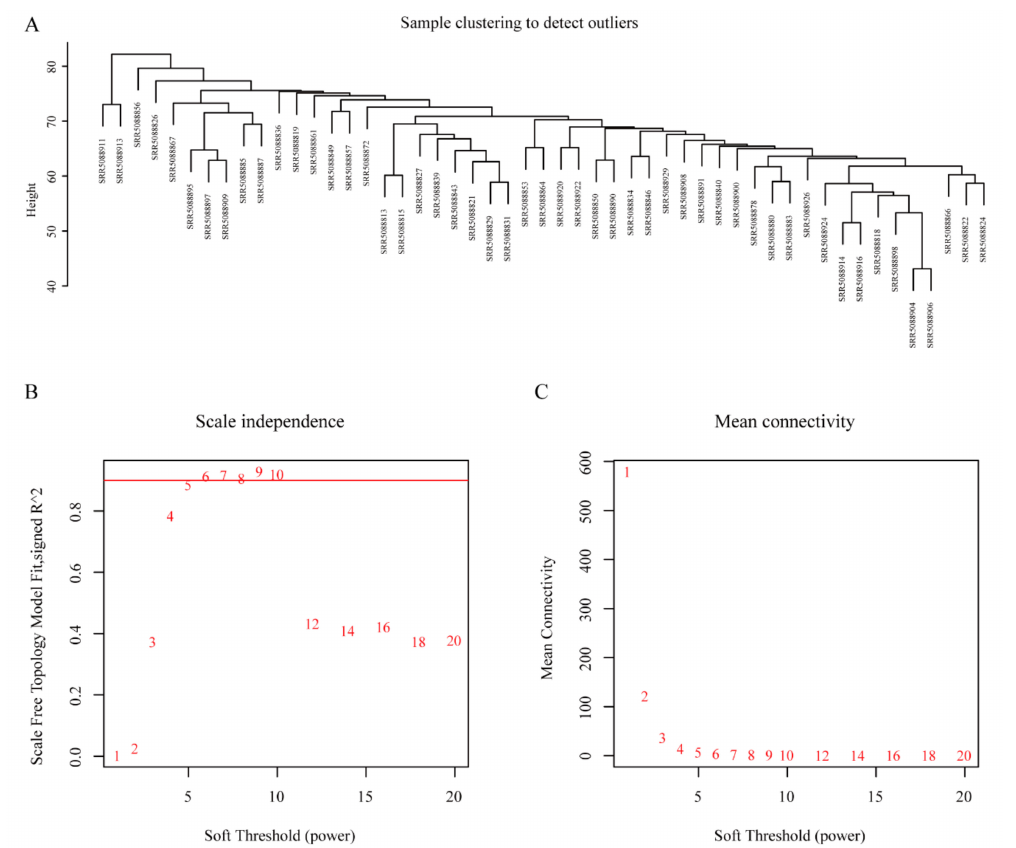
Figure 2. Sample clustering dendrogram and determination of soft-thresholding power in weighted gene co-expression network analysis (WGCNA). ( A ) Sample clustering dendrogram to detect outliers. ( B ) Analysis of the scale-free fit index for various soft-thresholding power. ( C ) Analysis of the mean connectivity for various soft-thresholding